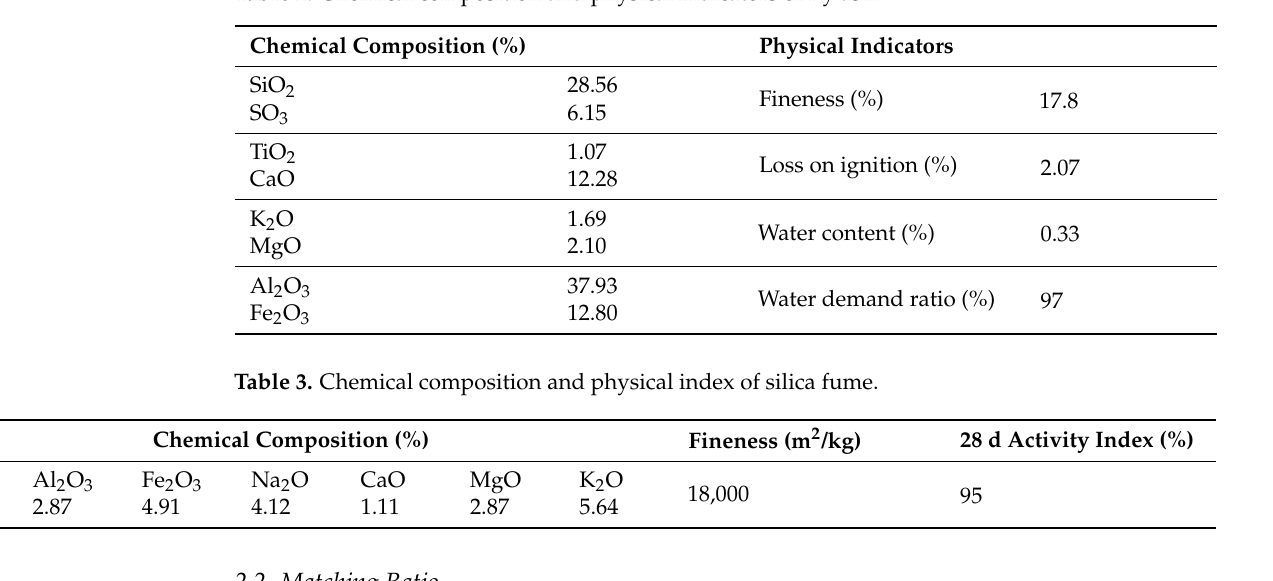
Table 2. Chemical composition and physical indicators of fly ash.